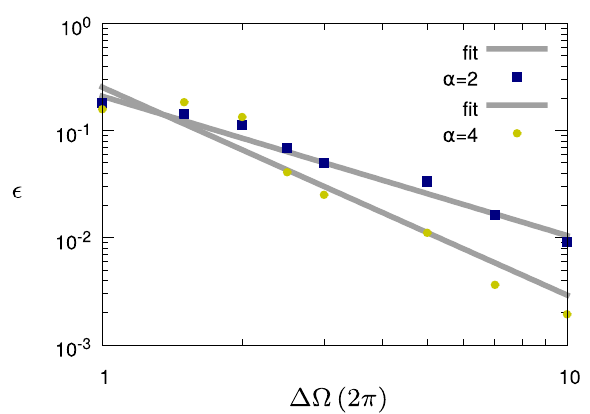
Figure 4. State transfer (“State transfer” section): Control error scaling with respect to the bandwidth (cid:31)(cid:30) of the control pulse for the 1 / f 2 - and 1 / f 4 -noise and state transfer between two random states. The time evolution is given by the Hamiltonian H 4 . For each pair of α and (cid:31)(cid:30) , the figure shows the maximum control error over all pairs of random initial and target states. For α whereby we have obtained a